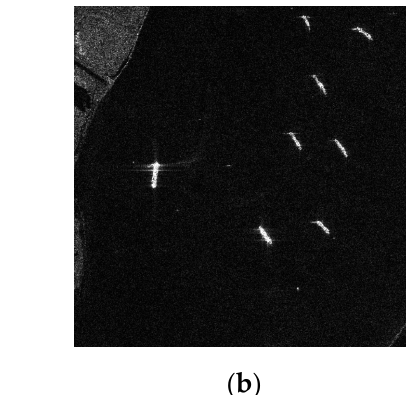
Table 1. Information of the images from the HRSID dataset .